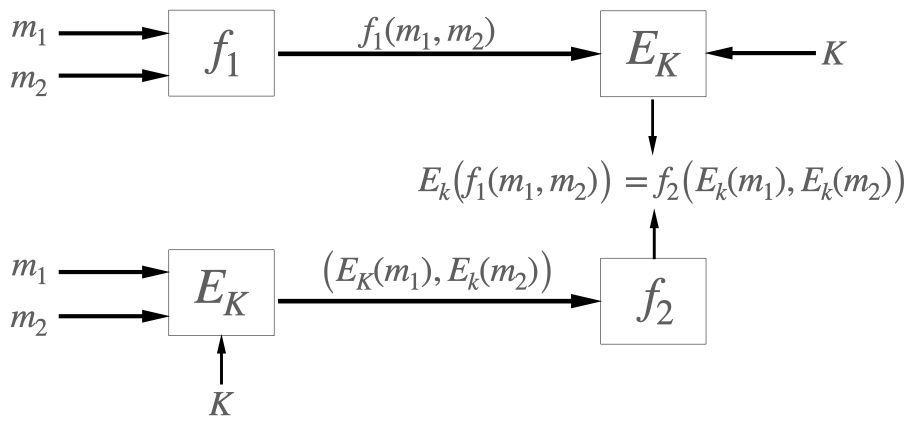
Figure 2. The encryption function E k : G 1 an element in a group G 1 and k an element in the space of keys and outputs an element of the group G 2. The functions f 1 : G 1 G 1 and G 2 , groups G 1 and G 2 respectively.